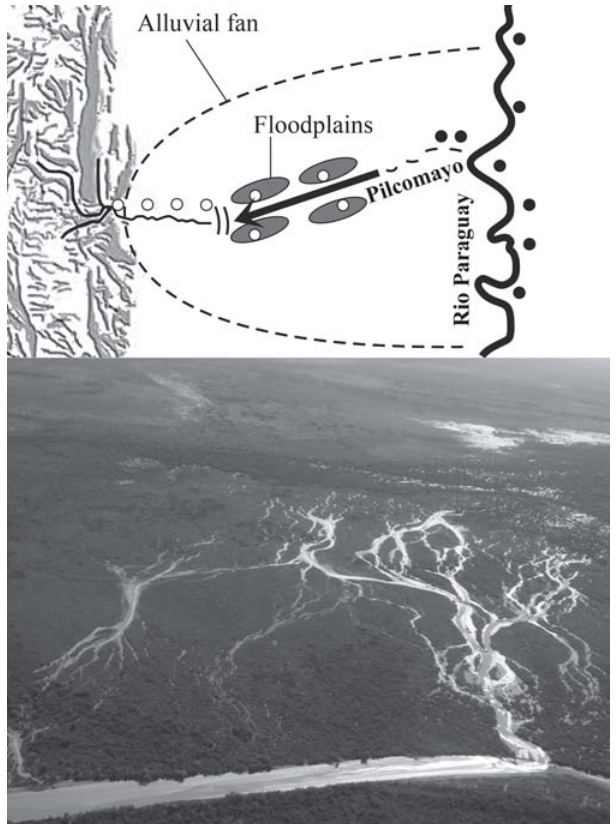
Fig. 6. Above: Retreat of the Pilcomayo River and dynamic creation of new flood plains due to self-blockage (silting up) of the river channel. This caused a retreat of hundreds of kilometers of the choke point in a few decades (indicated by the black arrow) and an upstream migration of the flood plains. Bullets indicate migrating Sábalo population in the Pilcomayo River (white) and Sábalo population in the La Plata basin (black). Below: Breakthrough of Pilcomayo River bank inundating new areas in the Chaco floodplain